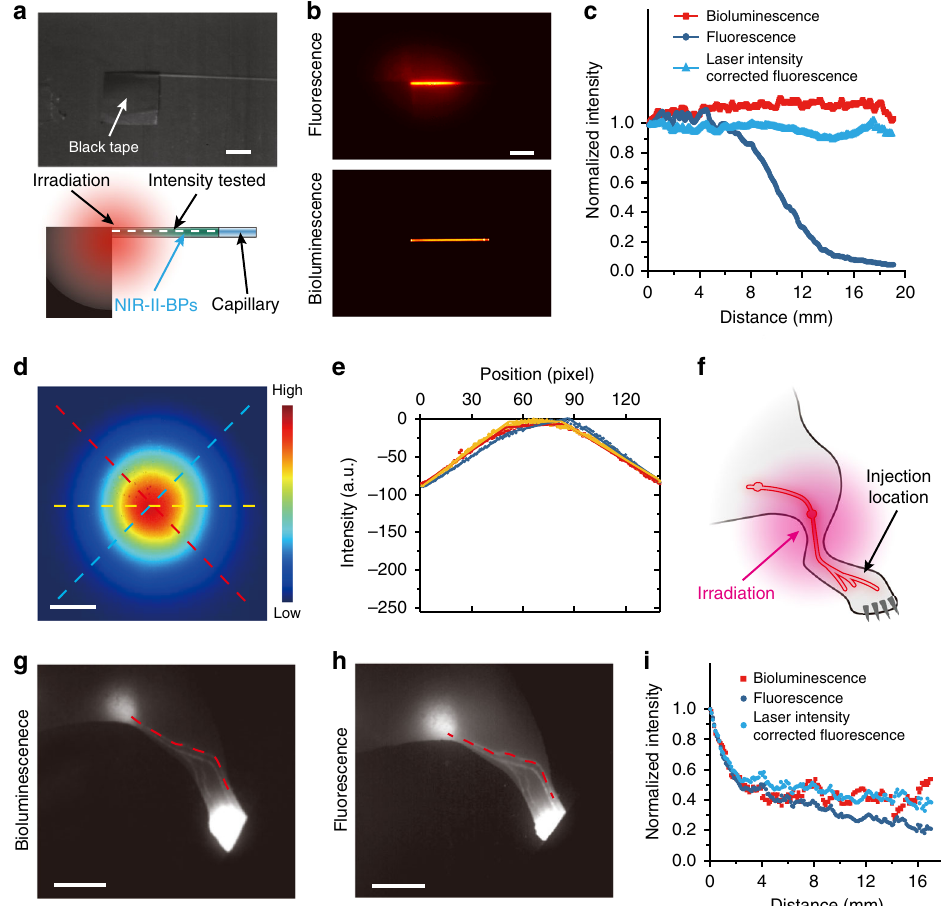
Fig. 4 In fl uence of the external excitation light on the signal uniformity of NIR-II bioluminescence and fl uorescence imaging. a Photo (top) and schematic illustration (bottom) of inhomogeneous illumination. Scale bar, 5 mm. b Optical images of capillaries fi lled with NIR-II-bps in NIR-II fl uorescence imaging with inhomogeneous illumination (top) and NIR-II bioluminescence imaging (bottom). Scale bar, 5 mm. c Intensity pro fi les along the capillary in g in NIR-II fl uorescence imaging and NIR-II bioluminescence imaging. d A typical Gaussian point spread function facula. Scale bar, 5 mm. e Intensity pro fi les along the dashed lines with the same color in a Gaussian point spread function in d . The positions in the calculations for the dashed lines were from upper left to lower right (red), upper right to lower left (blue), and left to right (yellow). Each scan has been approximated by three optimally determined line segments whose slopes are used in the quality factor (QF) calculation. f The illustration of in vivo study on inhomogeneous illumination. The NIR-II bioluminescence ( g ) and NIR-II fl uorescence ( h ) imaging on lymphatics in mice after intravenous injection of NIR-II-BPs. Scale bar, 5 mm. i Intensity pro fi les along the red dashed lines in g , h as well as the corrected intensity pro fi les considering the intensity distribution of the excitation light. Source data underlying c , e , i are provided as a Source Data fi